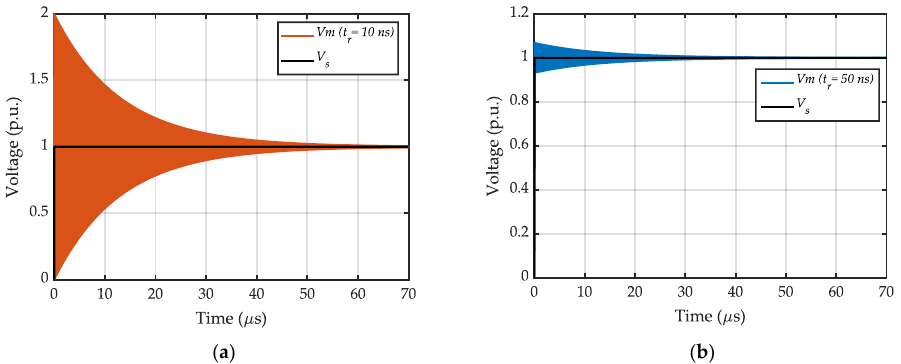
Figure 5. The voltage at motor terminals ( 𝑉 𝑚 ) when the motor is connected to the inverter through a cable with 𝑙 = 2 m and fed by a step voltage with ( a ) 𝑡 𝑟 = 10 ns; ( b ) 𝑡 𝑟 = 50 ns.